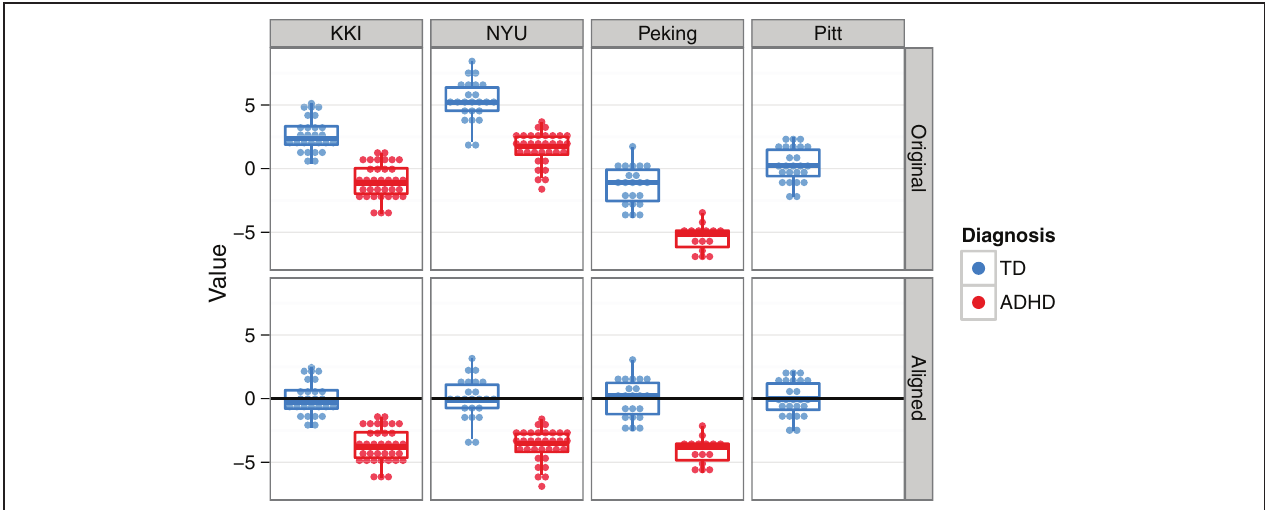
FIGURE 4 | Across-site alignment. For sites without complete training data (e.g., Pittsburgh), sites were aligned by their available subgroups (here, TD) and then an across-group classifier was trained. This schematic uses artificial data to demonstrate the procedure.